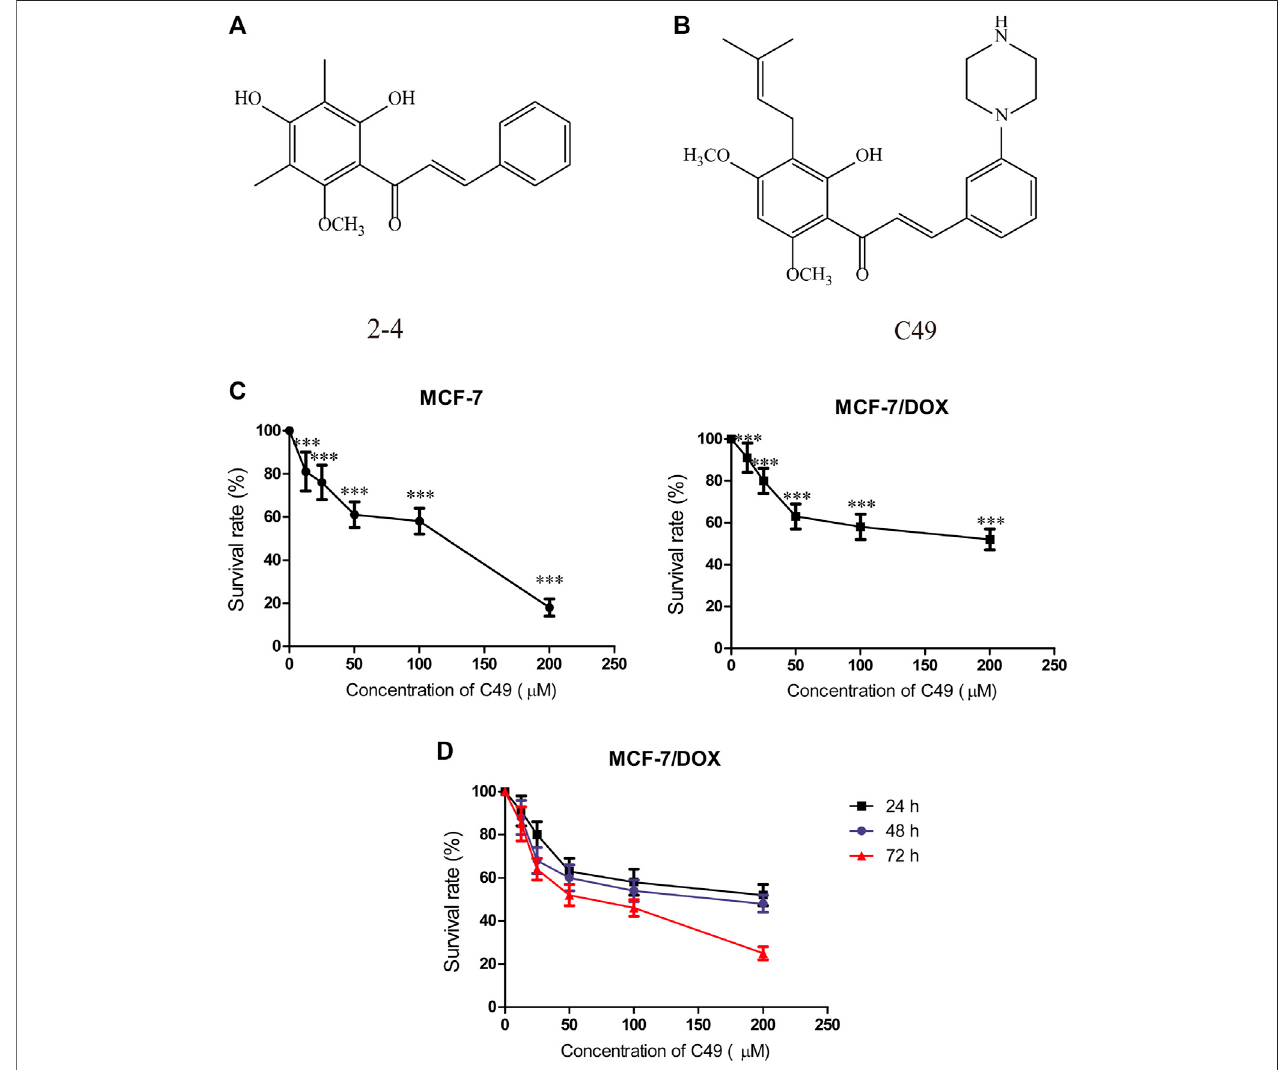
FIGURE 1 | Chemical structure of C49 and the effects of C49 on the viability of MCF-7 and MCF-7/DOX cells. (A – B) Chemical structures of C49 and its parent compound. (C) MCF-7cellsandMCF-7/DOXcellstreatedwithDOXfor48 h,andthecellviabilityassessedbyMTTassay. (D) MCF-7/DOXcellstreatedwithC49for24, 48 and 72 h. Viability quantitated by the MTT assay. Each point represents mean ± SD, n (cid:1) 3. * p < 0.05, ** p < 0.01, and *** p < 0.001.